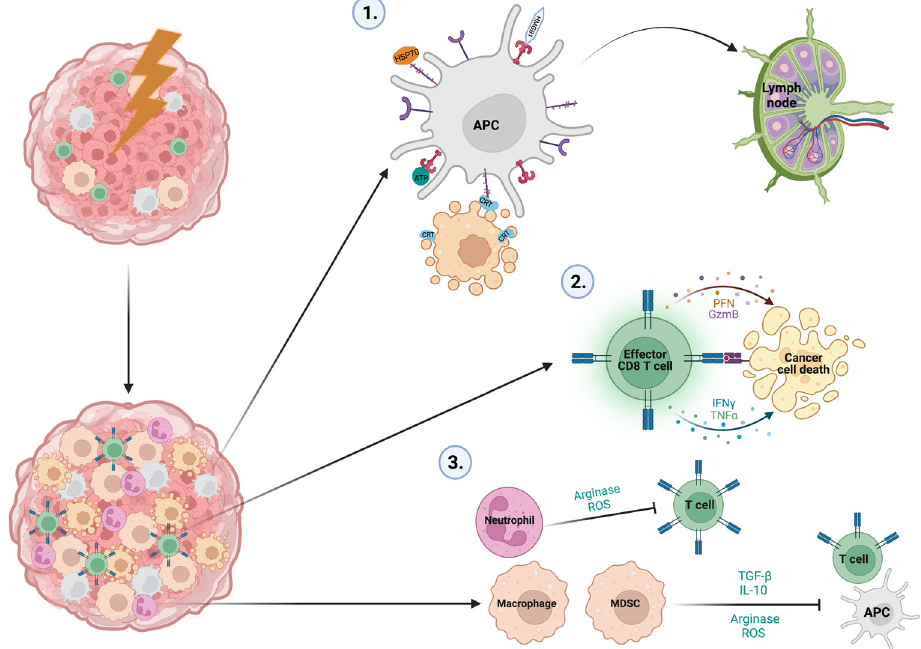
Figure 2. Key immune stimulatory and immunosuppressive events associated with IR treatment in cancer. Following IR, ICD results in the release of DAMPs, cytokines, chemokines and tumor antigens which activate APCs and induce the mass in fi ltration of myeloid and lymphoid cells. Three key immunological events occur following ICD which dictate the treatment response: (1) APCs internalize, process and present tumor antigens released by damaged tumor cells and migrate to the tumor draining lymph node to present these antigens to CD4 + and CD8 + T cells. (2) CD8 + T cells with receptors speci fi c to the tumor antigen localize to the tumor and kill cancers via the cytolytic enzymes perforin and granzyme B, along with the cytotoxic cytokines IFN- γ and TNF- α . (3) including IL-10 expression, which depletes MHC II on their surface, TGF- β , which polarizes CD4+